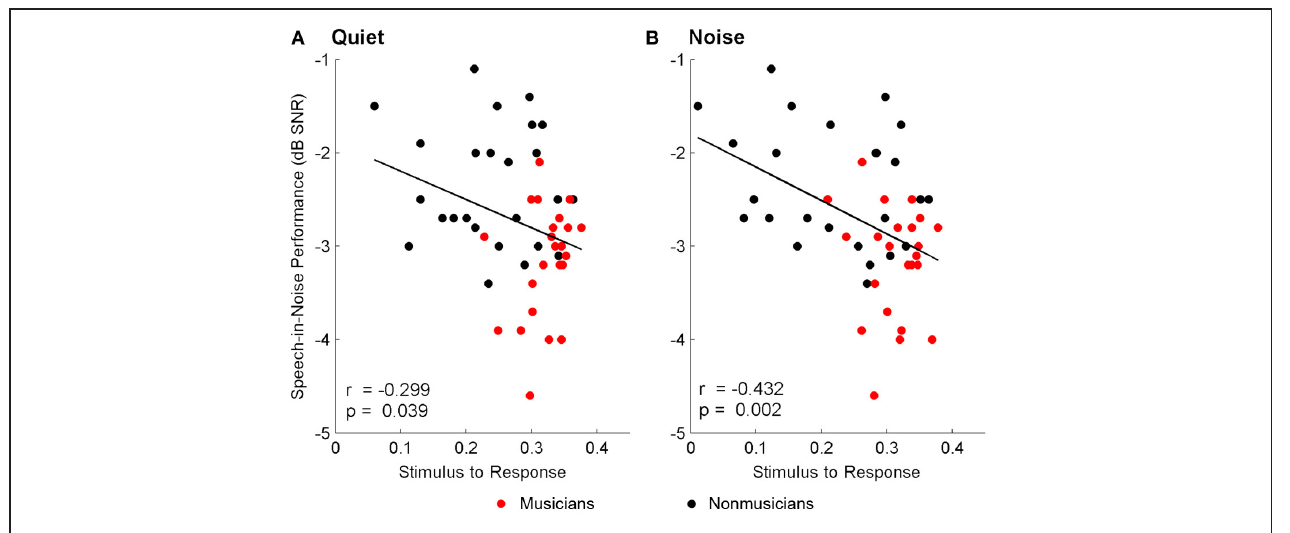
precision in the brainstem’s ability to represent the stimulus in both conditions is important for understanding speech in noise. A lower, more negative speech-in-noise score is indicative of better